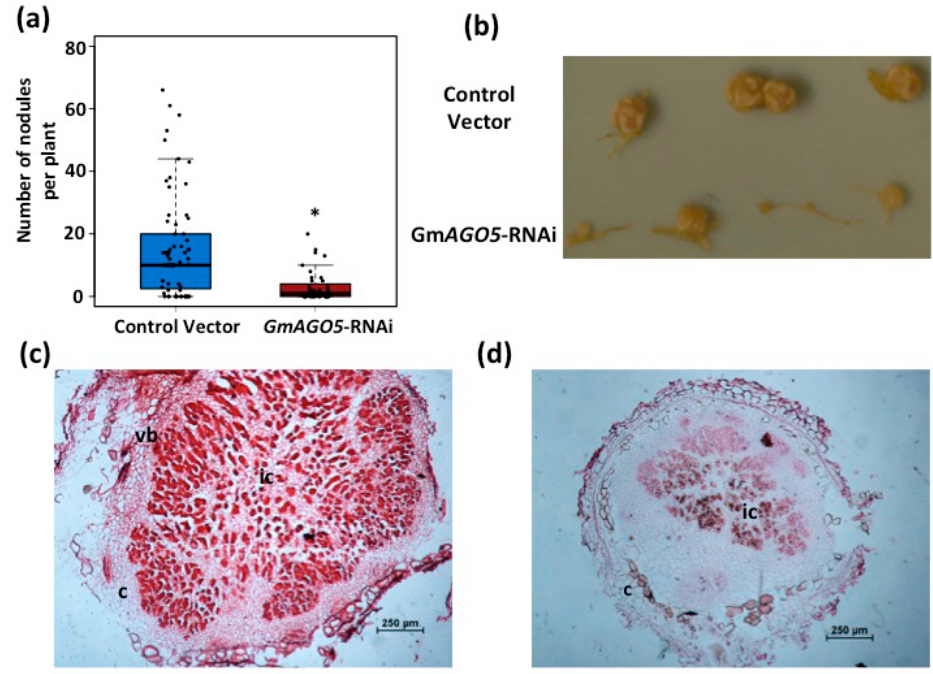
Figure 7. Down-regulation of AGO5 affects nodule development in soybean. ( a ) Nodulation assay on control- and GmAGO5 -silenced common bean transgenic roots. Data shown was obtained from 30 independent biological replicates. One-way ANOVA followed by a Tukey HSD test was performed. Asterisk indicates a significant difference ( p -value < 0.01); ( b ) Nodules observed in control- and PvAGO5 -silenced common bean transgenic roots. ( c , d ) Safranine-stained sections of B. japonicum -inoculated nodules showing the morphology and organization of representative samples collected from transgenic control ( c ) and GmAGO5 -RNAi ( d ) roots. c: Cortex; ic: infected cells; vb: vascular bundle.